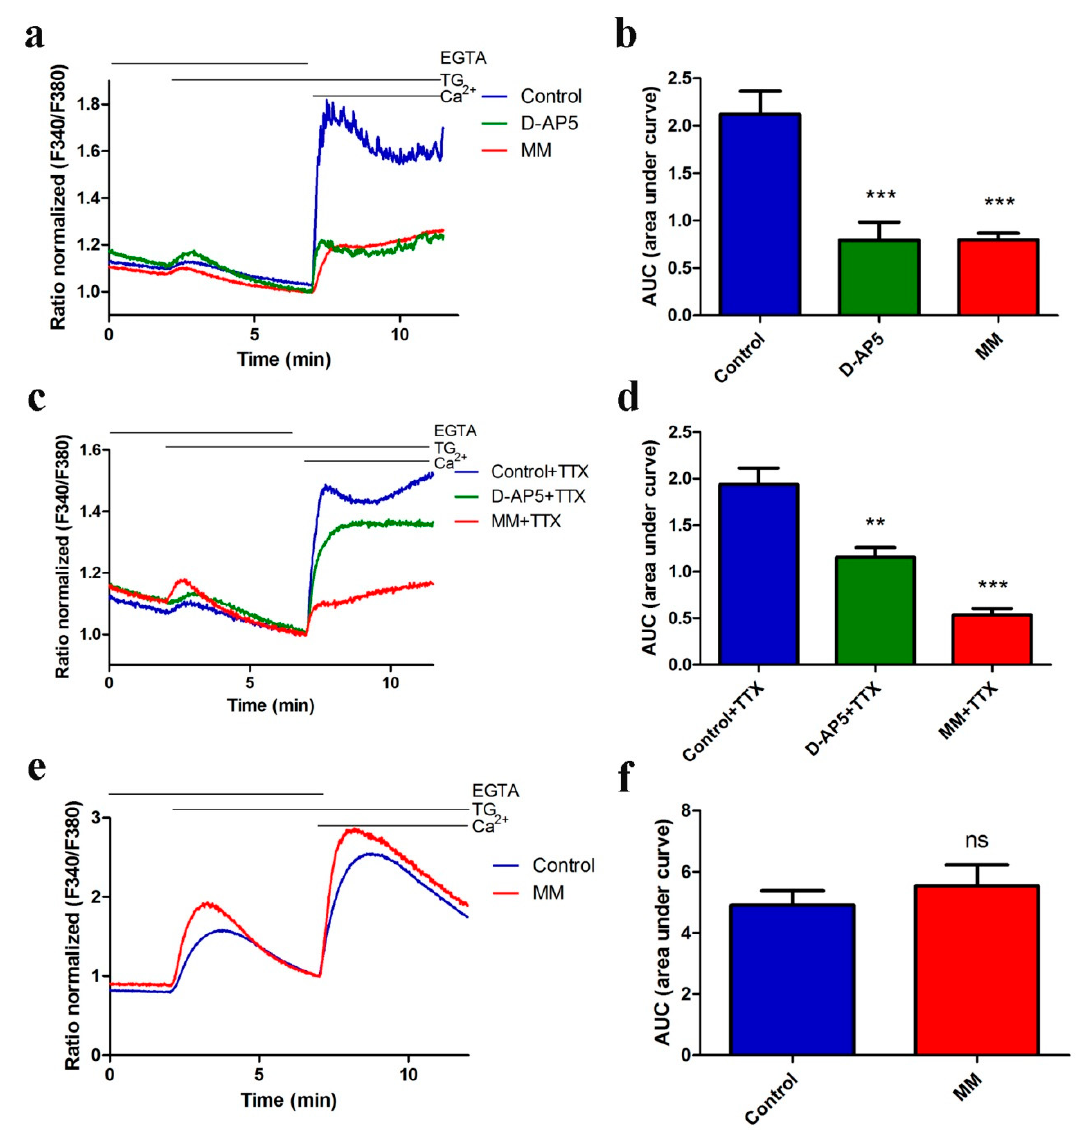
Figure 1. NMDAR antagonists block TG-induced SOCE in rat cortical neurons but not HeLa cells. Average traces of intracellular Ca 2 + (F340 / F380) levels obtained by ratiometric Fura-2AM analysis of neurons in the absence ( a ) or presence of 1 µ M TTX ( c ), or in HeLa cells ( e ) treated with 50 µ M D-AP5 (green line) or 50 µ M MM (red line) and untreated cells (blue line). Measurements were started in a medium with 0.5 mM EGTA, which was then replaced by a medium with 0.5 mM EGTA and either 2 µ M TG + 50 µ M D-AP5 or 2 µ M TG + 50 µ M MM. Finally, 2 mM CaCl 2 was added to the medium to trigger nSOCE with either 50 µ M D-AP5 or 50 µ M MM. F340 / F380 values just before the addition of Ca 2 + were normalized to the same values (1). ( a – d ) The data represent n = 28 (Control), n = 12 (D-AP5), n = 20 (MM), n = 15 (Control + TTX), n = 19 (D-AP5 + TTX) and n = 18 (MM + TTX) independent experiments that were conducted on five di ff erent primary cultures, corresponding to 1160, 513, 780, 336, 390, and 710 analyzed cells that responded to KCl-induced membrane depolarization, respectively. ( e – f ) The data represents 17 independent measurements conducted in four di ff erent experiments corresponding to 1333 for control and 1315 for MM treated cells, respectively. ( b , d , f ) Summary data of panels ( a , c , e ) presented as the area under the curve (AUC) showing Ca 2 + influx, which was calculated from the moment immediately before adding Ca 2 + from minutes 7 to 11; ns (not significant), ** p < 0.01, *** p < 0.001 significantly di ff erent compared with the control (Mann-Whitney U test). Data are expressed as the Delta Ratio ( ±